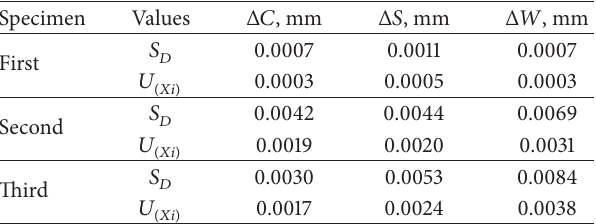
Table 5: The statistical results of tiles